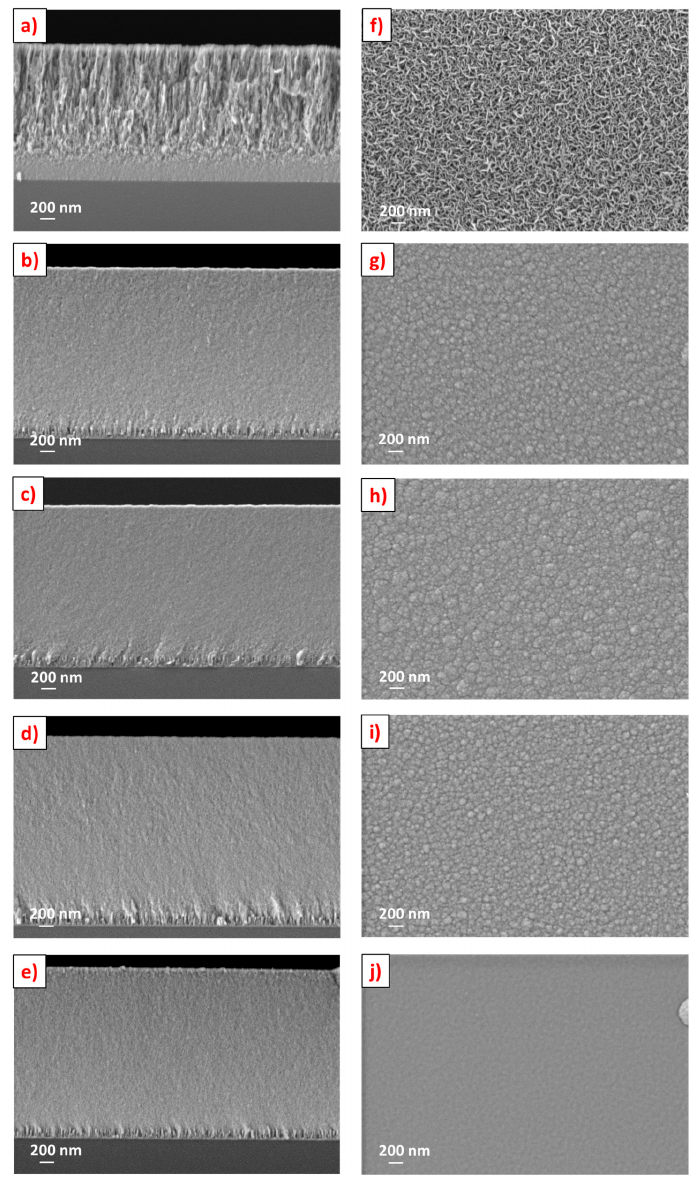
Figure 1. Scanning electron microscopy micrographs of the cross-section morphologies: ( a ) Pure MoSe 2 , ( b ) DC324, ( c ) DC540, ( d ) DC676, ( e ) DC540(50V) and their respective top surface morphologies: ( f ) Pure MoSe 2 , ( g ) DC324, ( h ) DC540, ( i ) DC676, ( j ) DC540(50V).